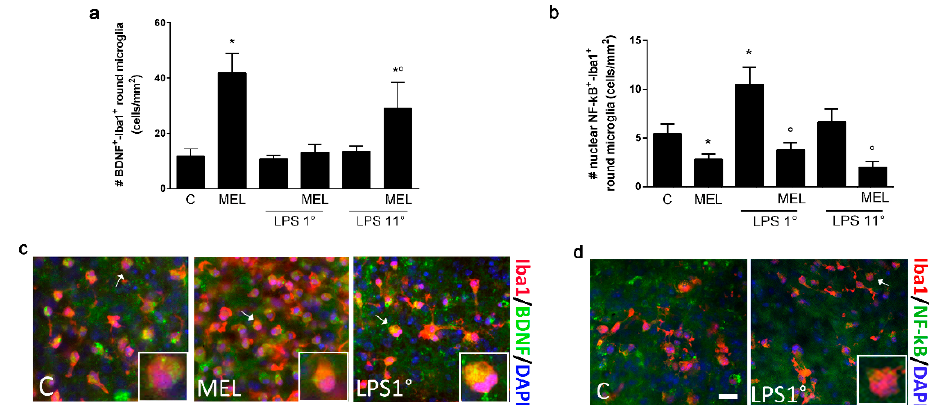
Figure 4. Differential polarization of round microglia. OCs were exposed to LPS (0.1 μ g/mL) for 24 h, either on the first day after culture (LPS 1°) or on the eleventh day (LPS 11°) and further cultured for a total of 14 days in vitro. Melatonin (MEL; 1 μ M) was added to OCs for 14 days, with or without LPS. Microglial cells were co-immunolabeled for Iba1+ with either BDNF or NF-kB. Cell counts of double-positive round cells for each group are reported in ( a , b ). Representative pictures are shown in ( c ) (Iba1 + /red and BDNF + /green) and ( d ) (Iba1 + /red and NF-kB + /green). Nuclei are counterstained with DAPI (blue, ( c , d )). Insets show a detail of the single cells indicated by the arrows, magnified 2.5×. Scale bar = 25 μ m. Data are mean ± SEM with n = 3. * p < 0.05 vs. C (over bars in ( a , b )) and ° p < 0.05 vs. respective LPS (over bars in ( a , b )) by one-way ANOVA followed by Fisher’s LSD test for significance.